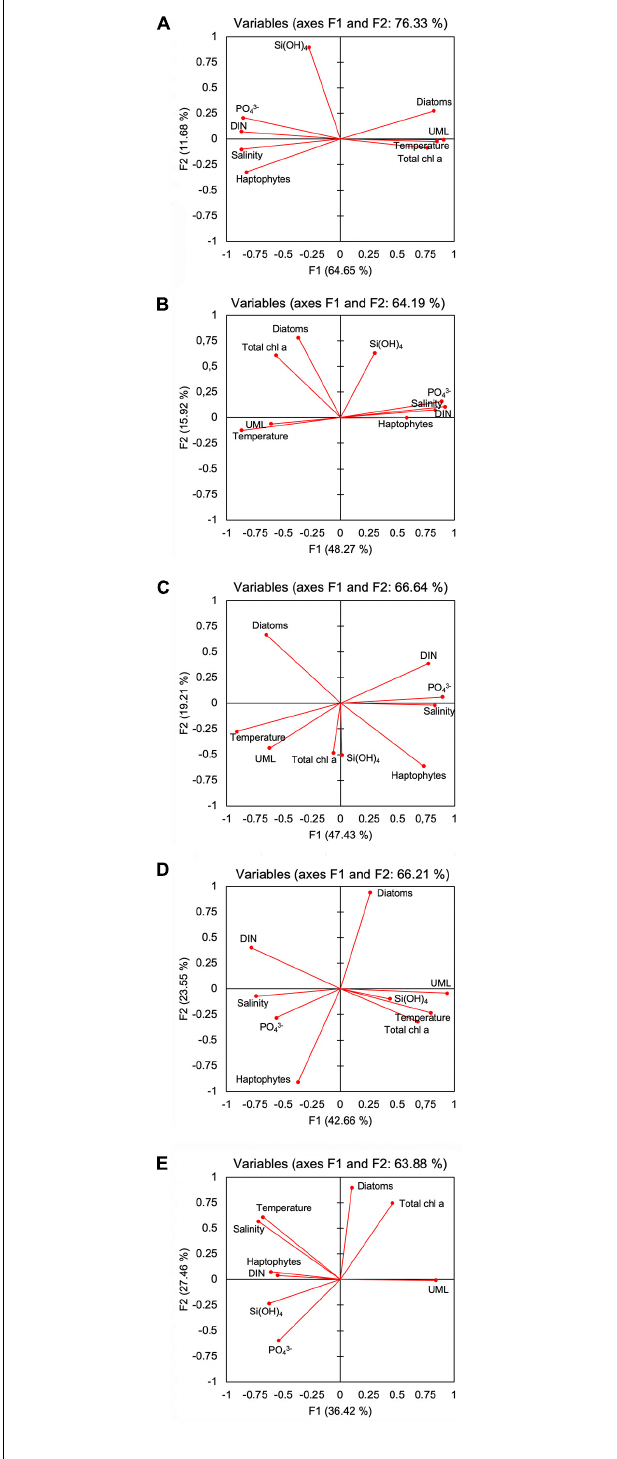
FIGURE 9 | Correlation plot from Principal Component Analysis (PCA) on axes F1 and F2, with projection of variables biological (chl a; percentage contribution of diatoms and haptophytes to total biomass) and environmental variables (salinity; temperature; dissolved inorganic nitrogen, NO 2 + NO 3 − , silicate, Si(OH) 4 ; phosphate, PO 43 − ; upper mixed layer, UML) for Area 1 (A) , 2 (B) , 3a (C) , 3b (D) , and 4 (E) in the factors